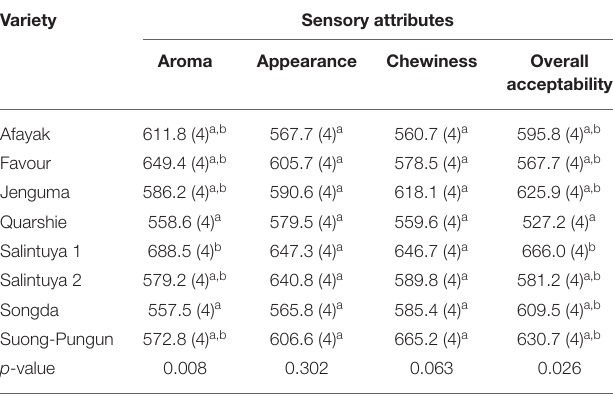
TABLE 3 | Consumer acceptability of Tofu from different